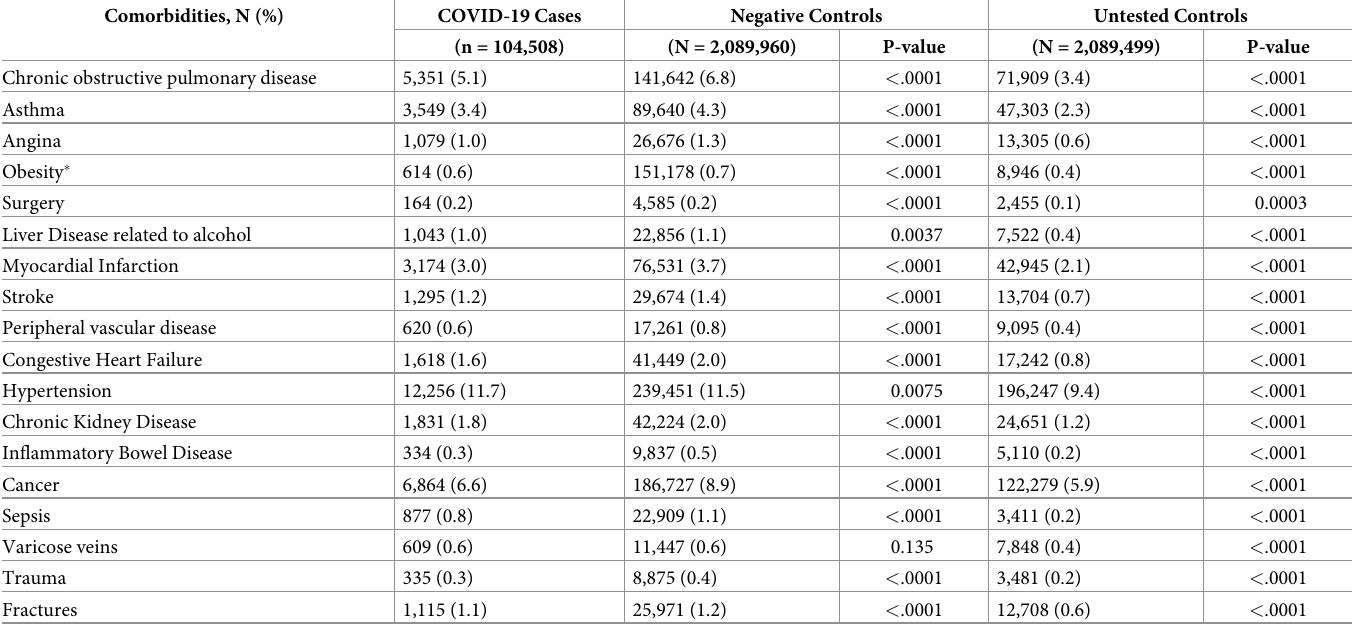
Table 2. Comorbidities in the year prior to index date for COVID-19 cases, negative controls, and untested controls. Comorbidities, N